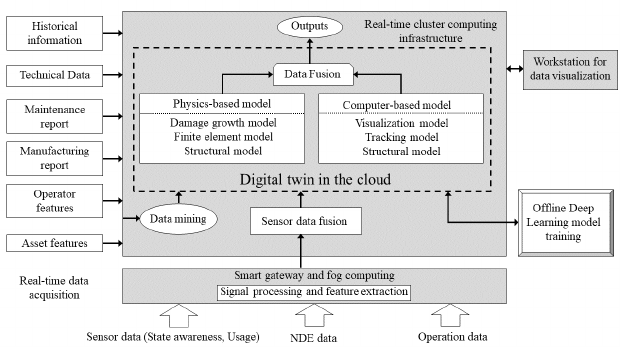
Figure 11. System architecture of digital twin ecosystem (After